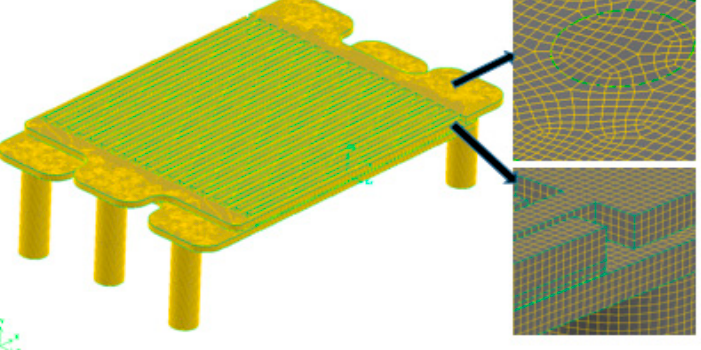
Figure 3. Meshes of the one-cell SOFC stack model and the local enlarged picture illustrates the mesh quality.